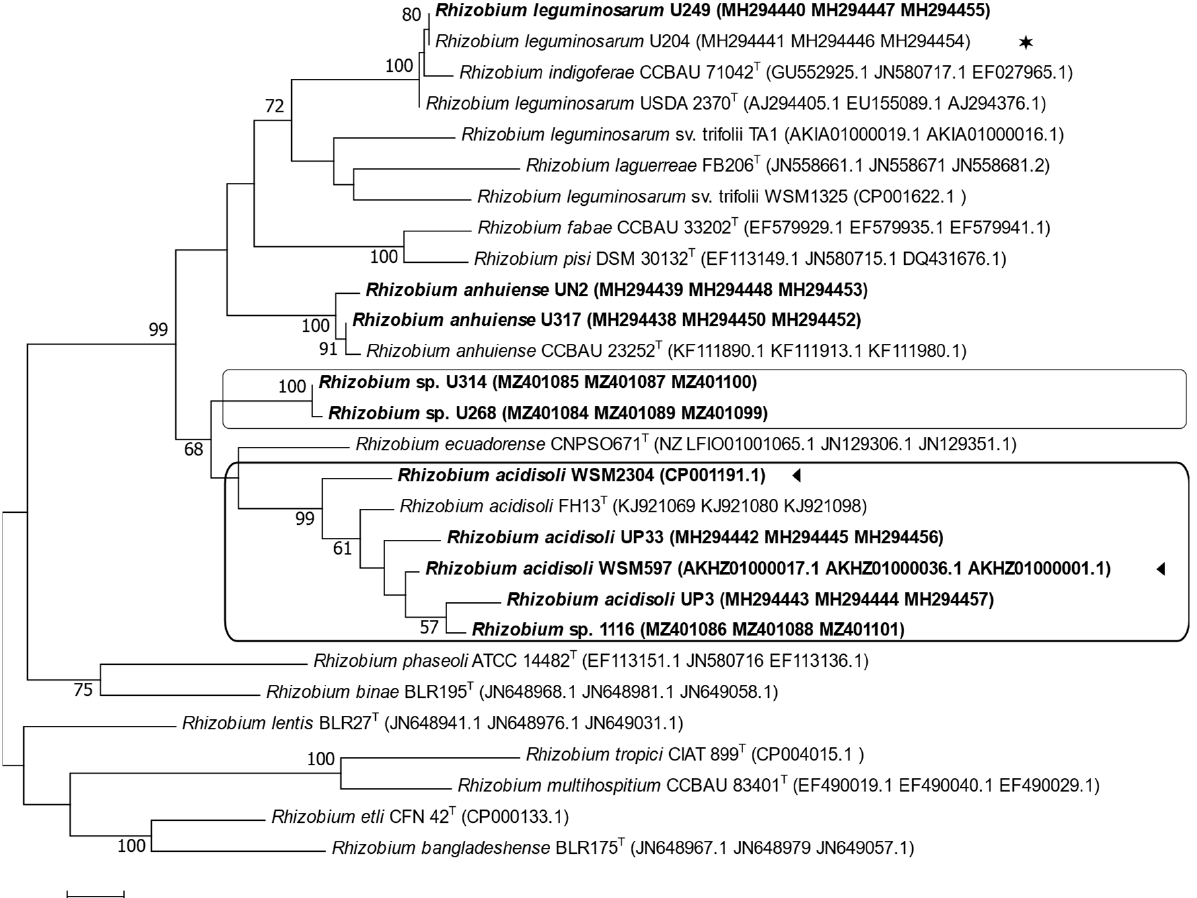
Figure 1. Nodule morphology. ( A ) Staining of nodulated roots of T. repens plants collected 21 days after seed co-inoculation. Magnification: 10X. ( B ) Staining of nodulated roots of T. repens plants col- lected at 35 dpi with U204 and UP3:: gusA . Magnification: 3X. Nodules infected with UP3:: gusA are indicated with white stars compared with non-stained nodules from U204 in black stars. Partially stained nodules are indicated with green stars.